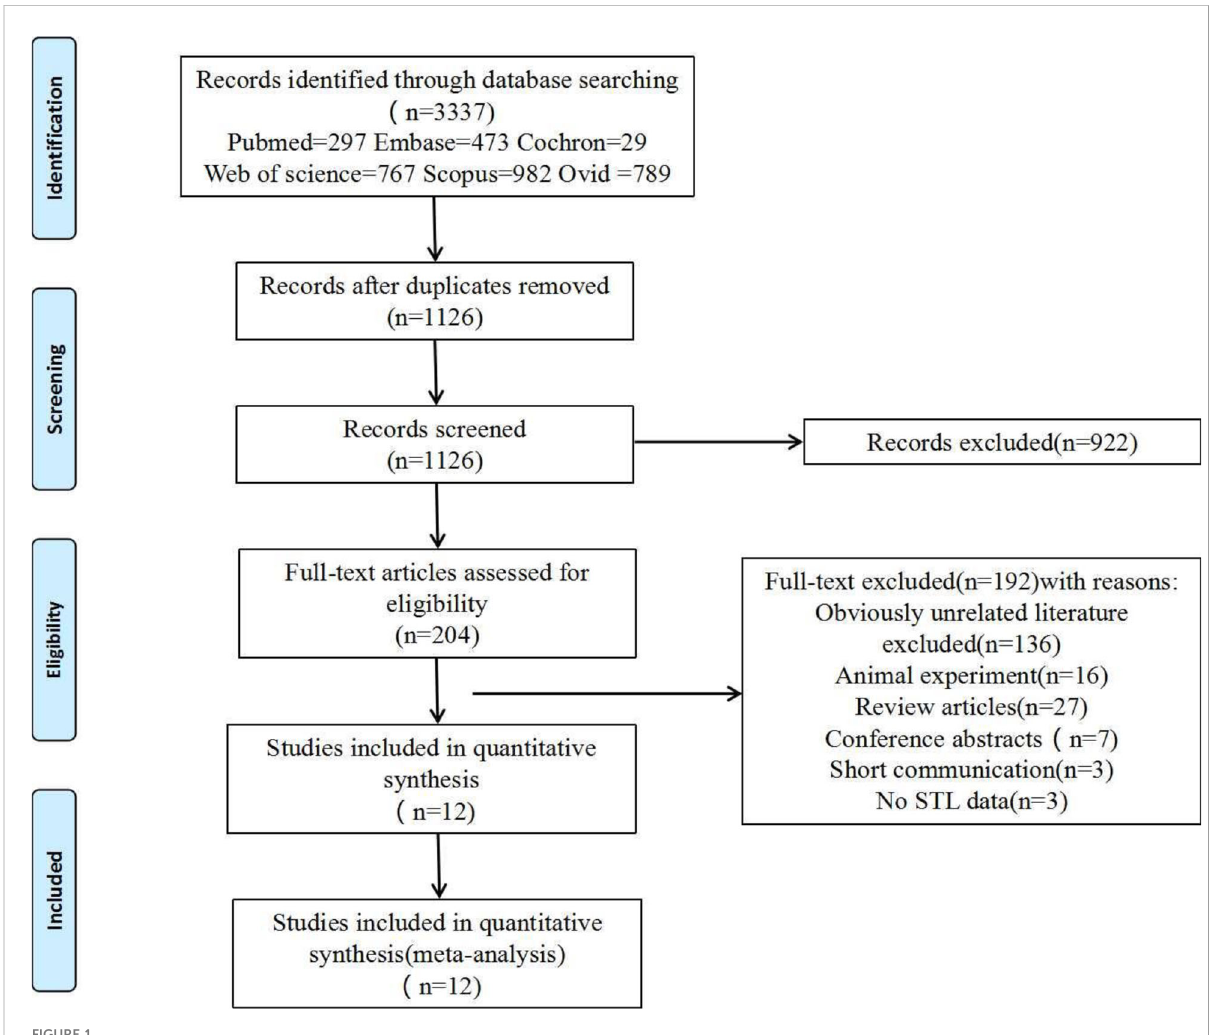
FIGURE 1 Flow of studies through the